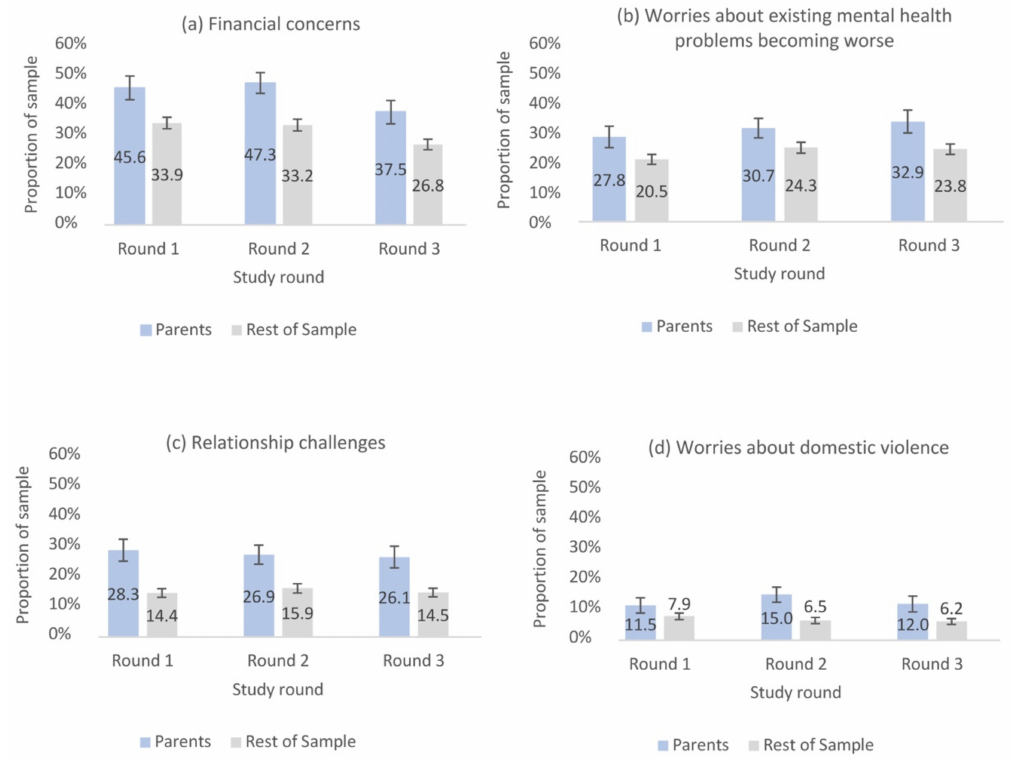
Figure 1. Proportion of parents compared with the rest of the sample reporting pandemic-related stressors, by study round (error bars represent 95% confidence intervals); ( a ) Financial concerns, ( b ) Worries about existing mental health problems becoming worse, ( c ) Relationship challenges, ( d ) Worries about domestic